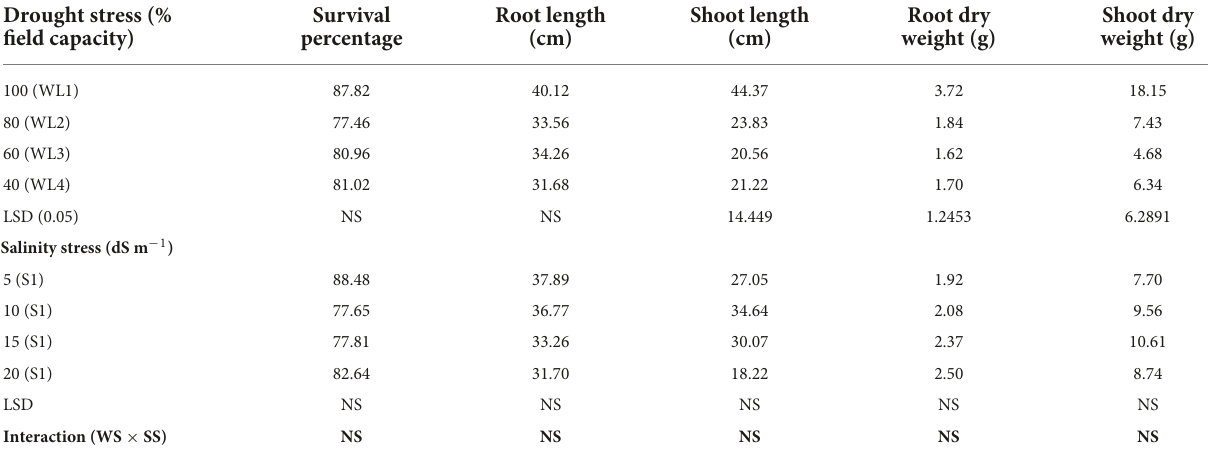
TABLE 2 Morphological response of Atriplex leucoclada to varying drought and salinity stresses. Drought stress (% field capacity)